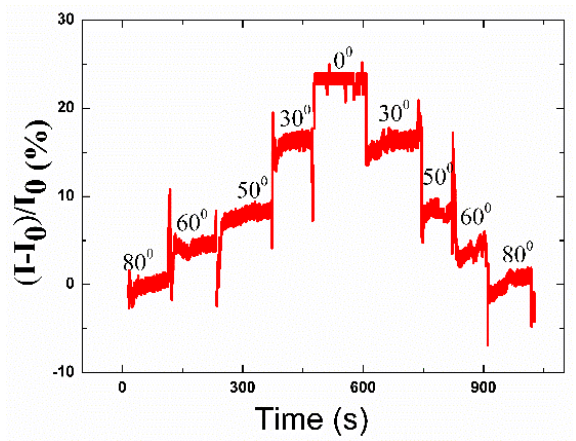
Figure 6. The currents of the strain sensor facing bending of various angles.